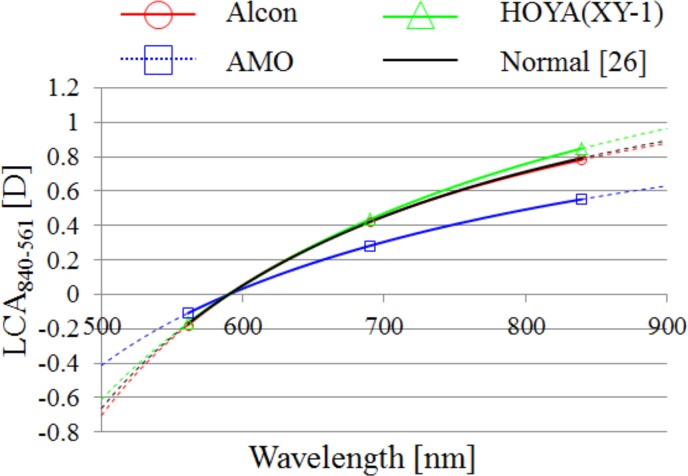
The Cauchyʼs fittings for each average of LCA.Fittings were plotted using the wavelength 590 nm as an offset wavelength. Dotted lines indicate extrapolations of regressions. Symbols indicate measured points for each IOL.